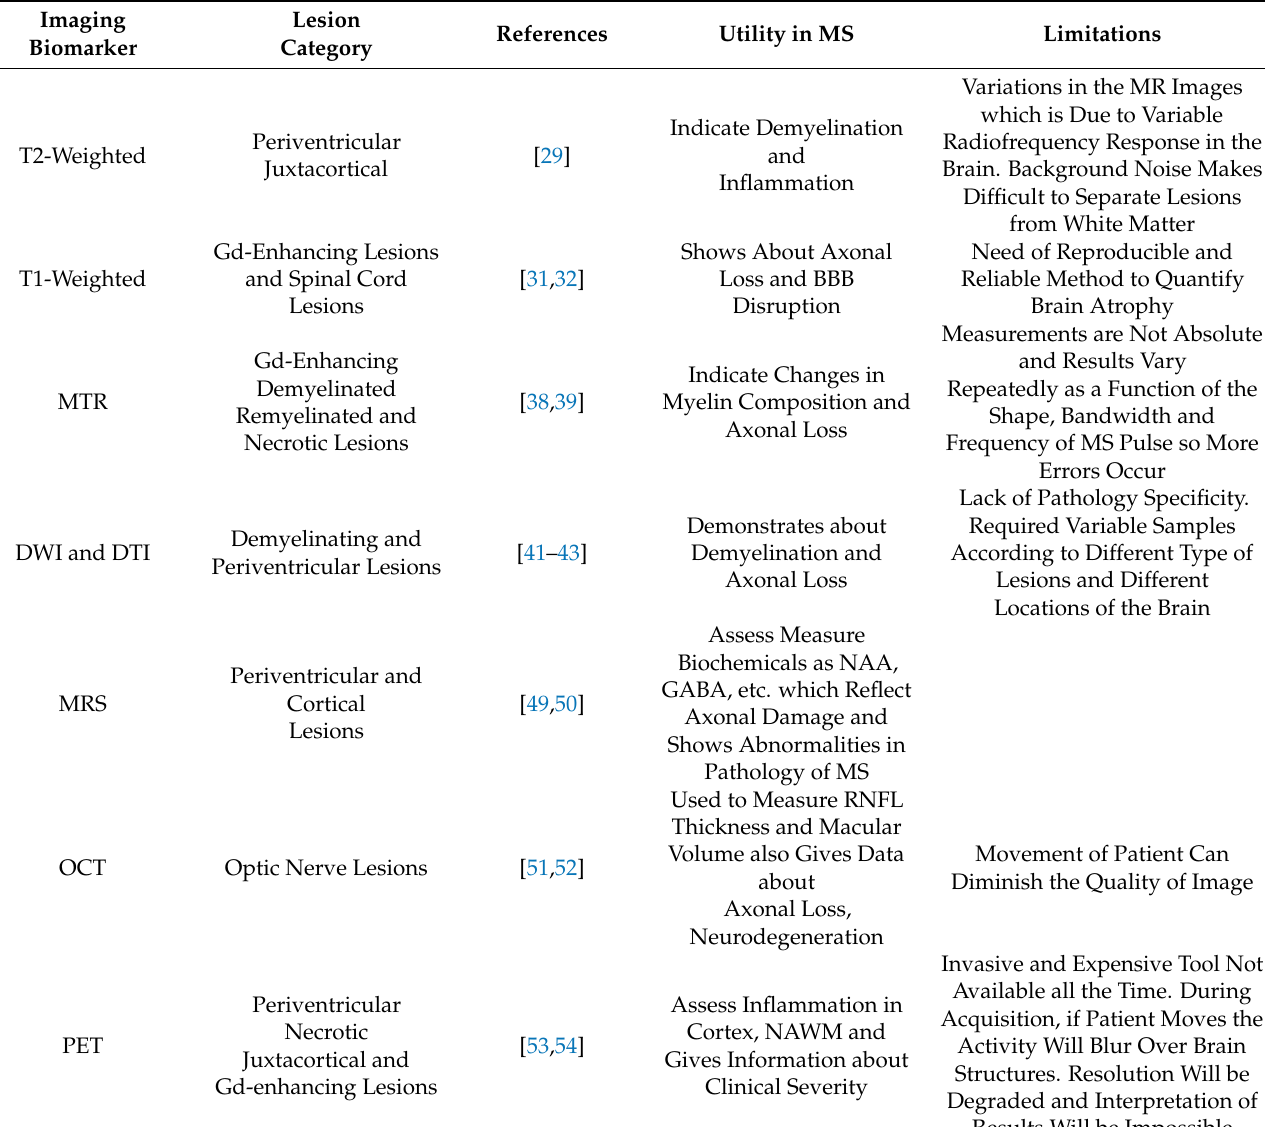
Table 3. Currently imaging biomarkers used in MS, lesions that are mainly detected, and utility and limitations of each